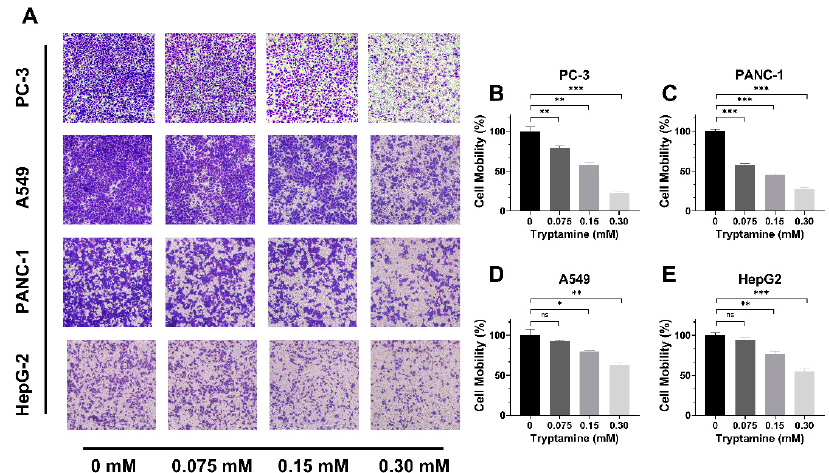
Figure 4. Migration of PC-3, PANC-1, A549, and HepG2 cells after treatment with different concen- trations of tryptamine for 24 h. ( A ) Migrated cancer cells photographed at 100 × magnification field. ( B – E ) Mobilities of PC-3, PANC-1, A549, and HepG-2 cells after incubation of different concentrations of tryptamine for 24 h. ns p > 0.05, * p < 0.05, ** p < 0.01, *** p < 0.001, n = 3.